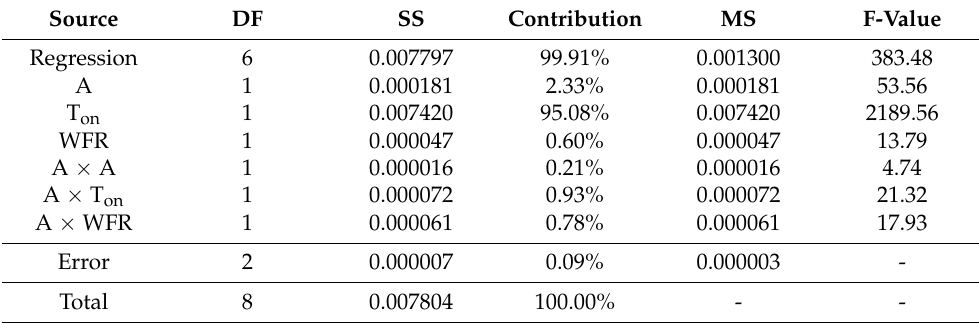
Table 1. Analysis of variance: kerf width—Al6351–5% SiC–0% B 4